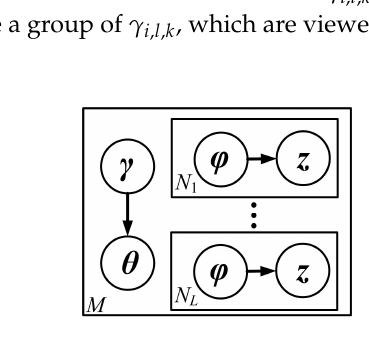
Figure 6. Graphical representation of the variational distribution used to approximate the likelihood function in the proposed AI-MFLDA method.